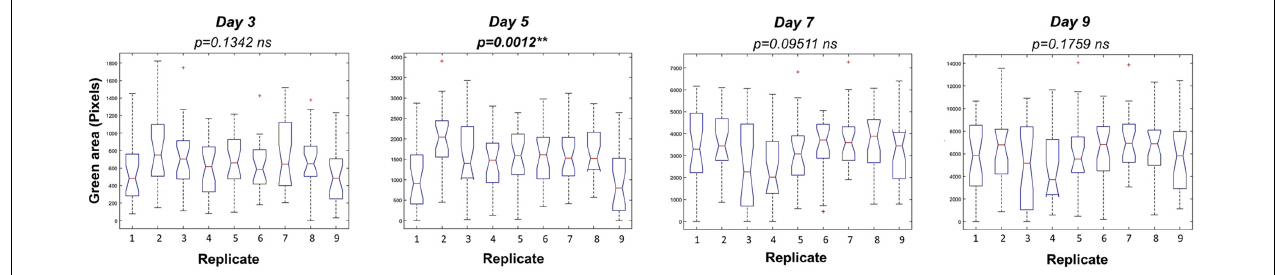
FIGURE 5 | Variation among replicates in Arabidopsis rosette growth under control conditions after seedling selection. Box plots representing the green area of 4 DAG Arabidopsis seedlings grown in 24-well plates (9 biological replicates) with 1 × MS medium for 9 days. Statistical analysis was performed using Kruskal–Wallis’ test ∗∗ p < 0.01; ns – non-significant.